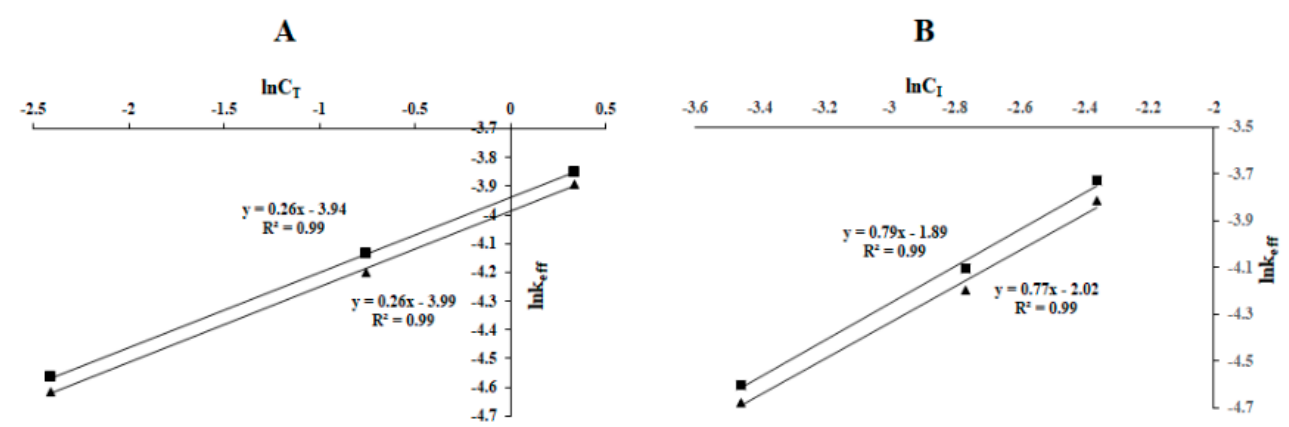
Figure 4. Dependence in coordinates “ lnk ef f vs. lnC T ” (AIBN concentration is 6.30 × 10 − 2 mol × l − 1 )— A and lnk ef f vs. lnC I (mercapto acids concentration is 0.47 mol × l − 1 )— B at temperature 343 К .